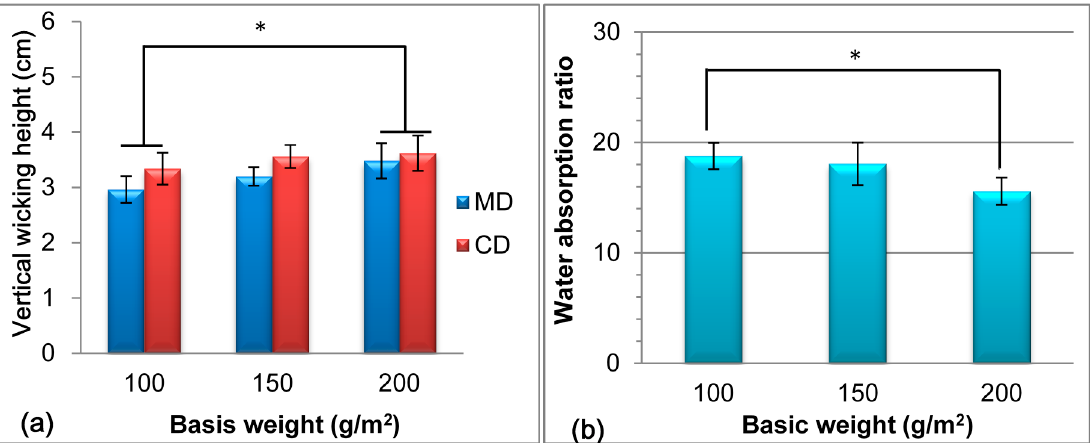
Figure 4. ( a ) Vertical wicking height and ( b ) water absorption of TCP nonwovens with various basal weights. * p < 0.05.